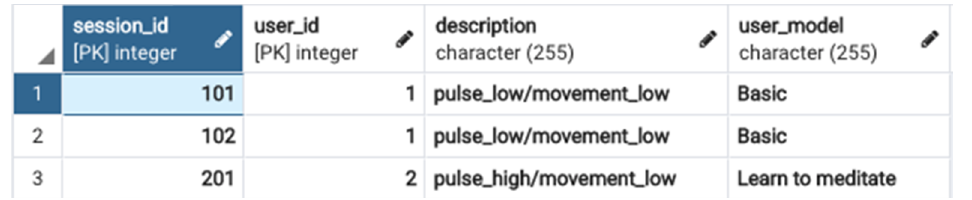
Figure 26. Example of data in the “Sensor_Data” table. Figure 24. Database structure for meditation practices.